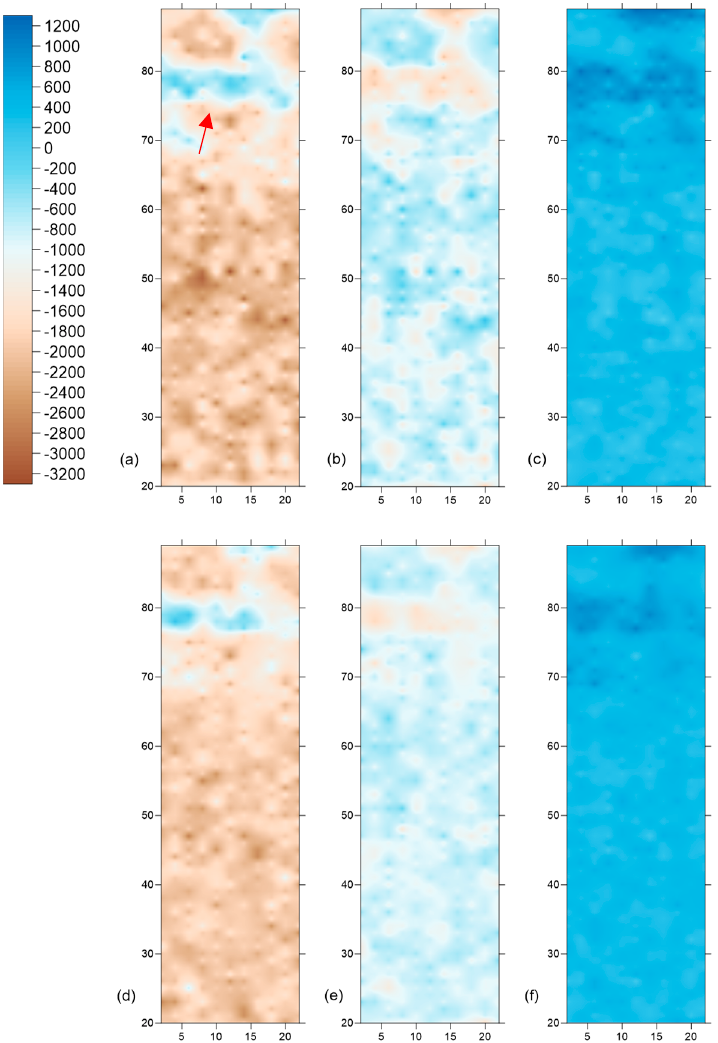
Figure 12. GPR depth slices results for 0.00–0.20 m ( a ), 0.20–0.40 m ( b ), and 0.40–0.60 m ( c ) below ground surface and BNN fused results for 0.00–0.20 m ( d ), 0.20–0.40 m ( e ), and 0.40–0.60 m ( f ) below ground surface using the hyperspectral vegetation cluster. All depth slices have been rescaled to the same GPR amplitude range for consistency in the interpretation of the figure. High amplitude values are shown with blue color, while low amplitude values are shown with brown.